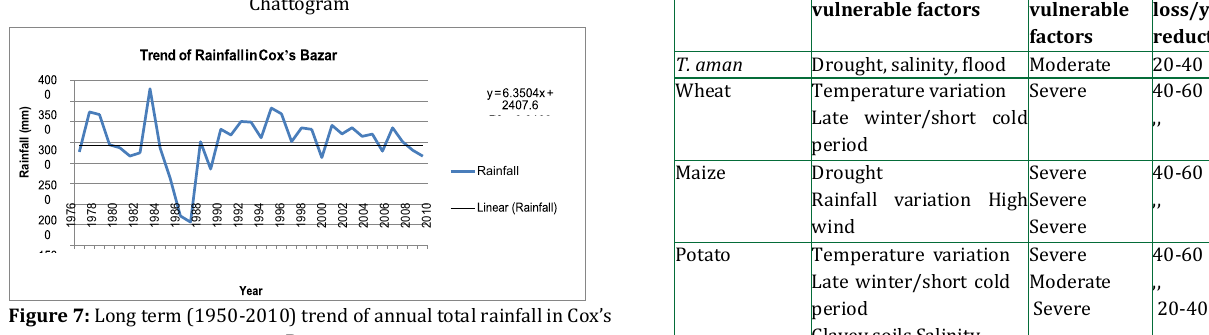
Figure 6: Long term (1950-2010) trend of annual total rainfall in